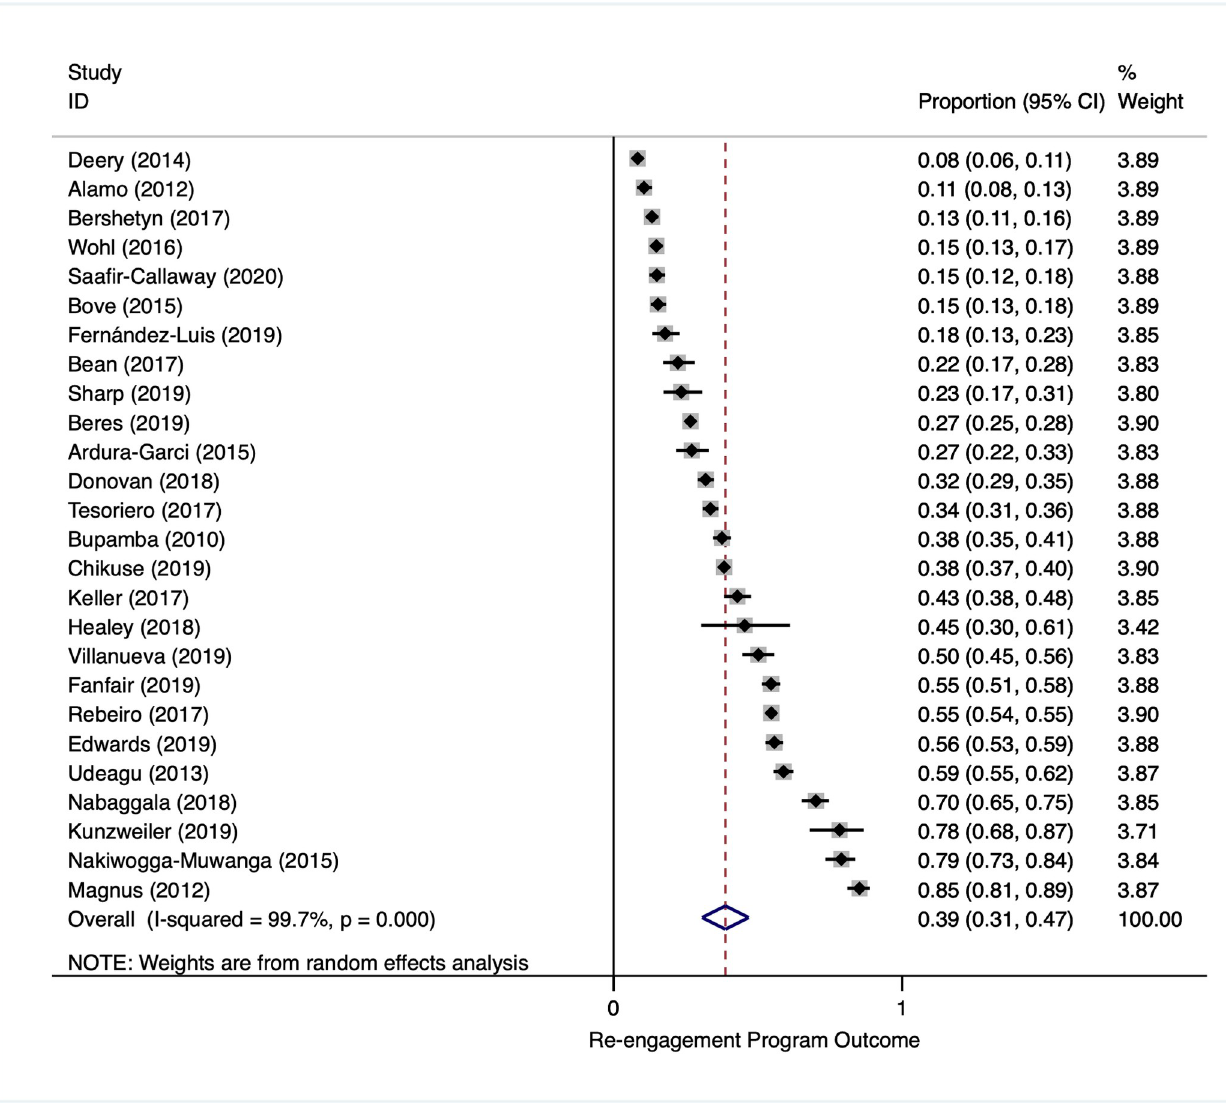
Fig 4. Reengagement program outcome: proportion returned to care among all identified as LTFU (in intervention study arms). LTFU, lost to follow-up.